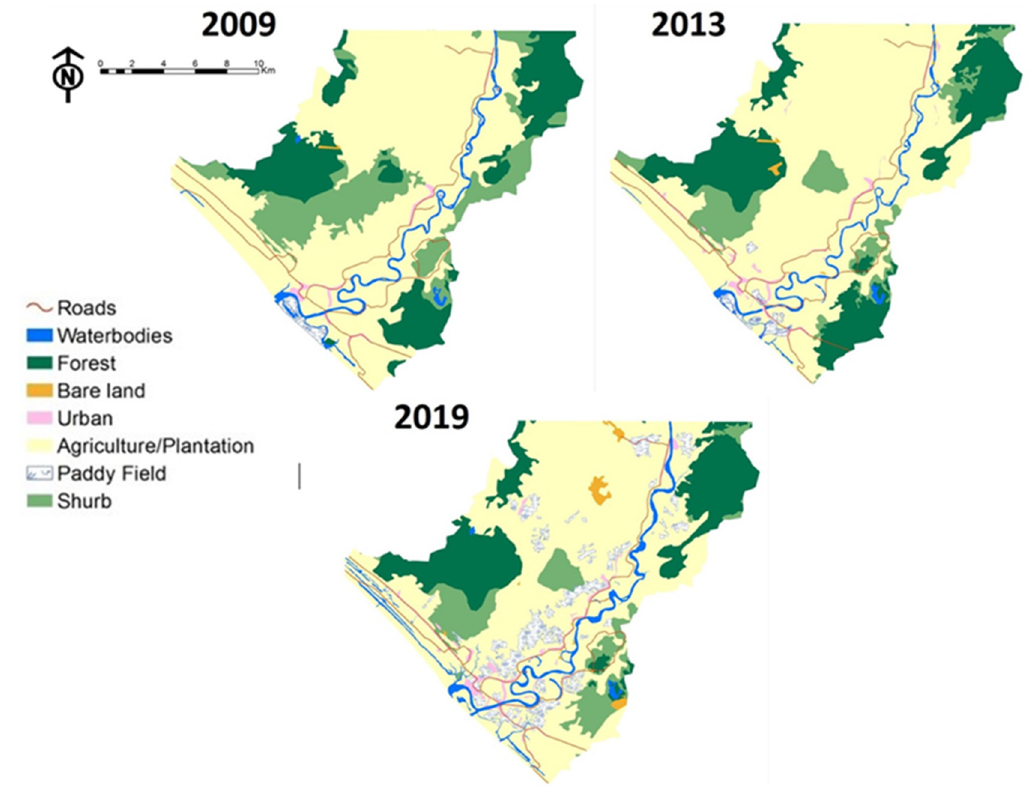
Figure 4. Spatial map of Krueng Teunom watershed land use from 2009 to 2019. Figure 5. Spatial map of Krueng Teunom watershed land use from 2009 to Table 2. Land cover change data from 2009 to 2019.